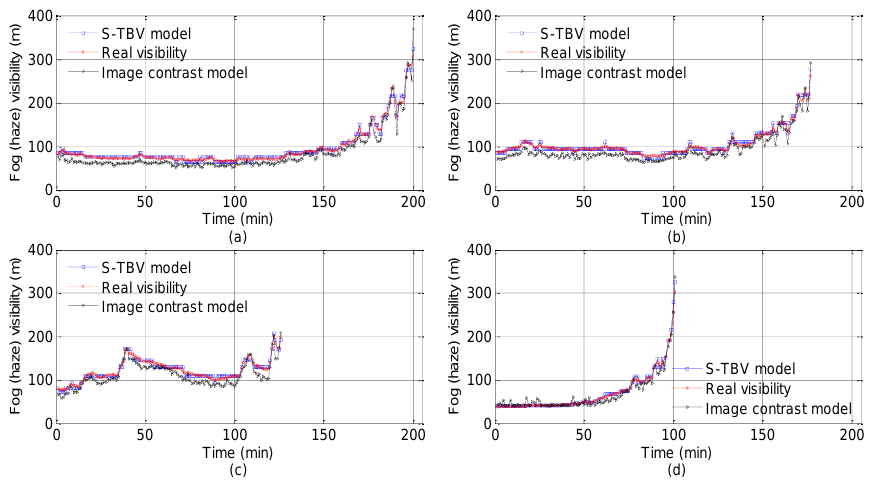
Figure 7. Visibility comparisons among the real values, the estimation results of the TBV approach and the results of the image contrast model (The visibility values shown in ( a – d ) are corresponding to the Points 2, 4, 5, and 6, respectively.).